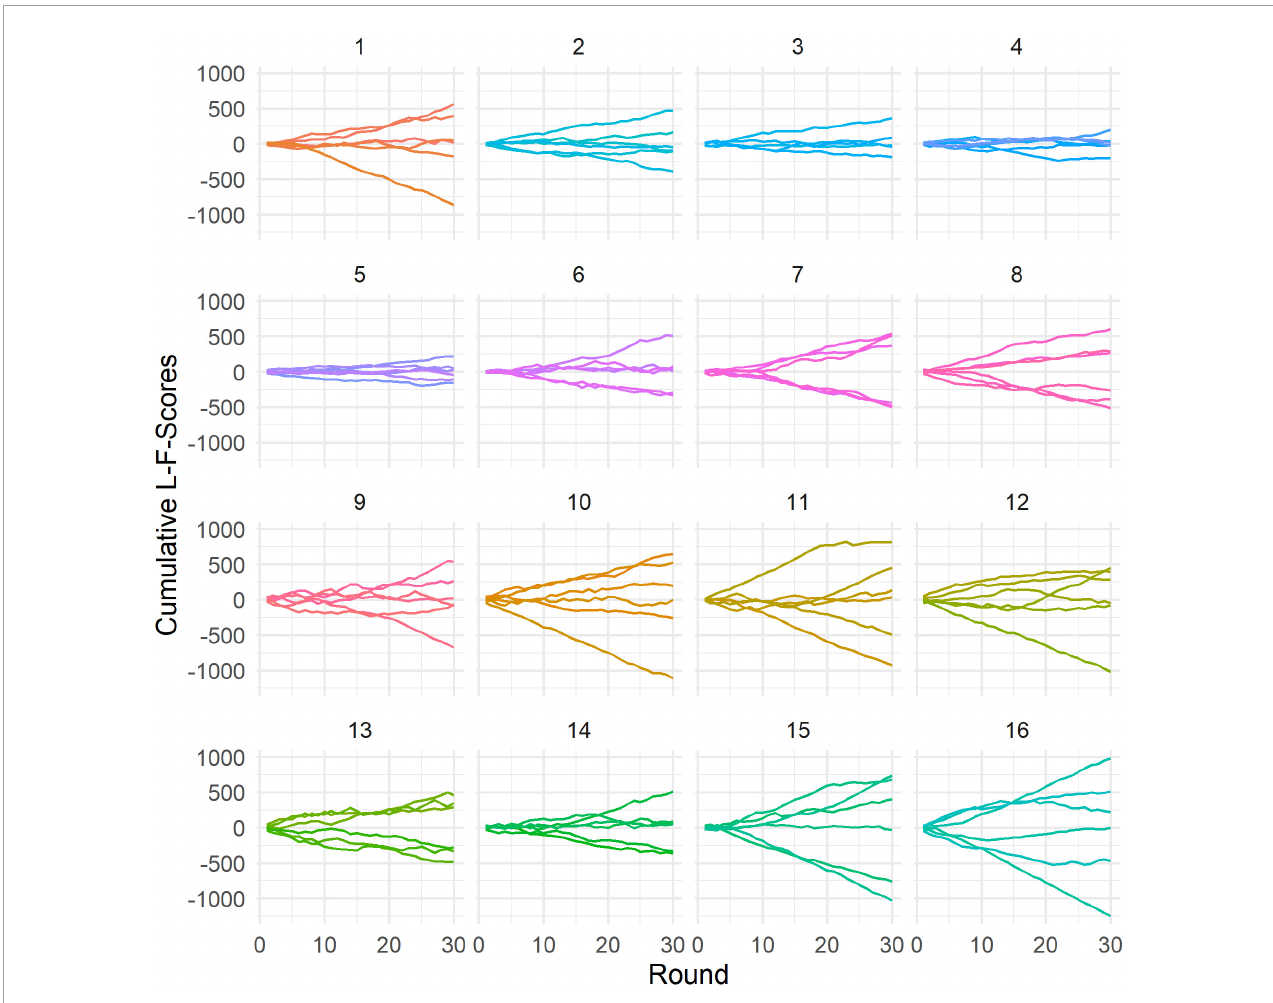
FIGURE7 Cumulative L-F-score sums over rounds. Each panel shows data from one group. Each line represents the cumulative L-F-score sum of one individual participant. Higher scores represent leadership behavioral patterns, while lower scores represent followership behavioral patterns. More divergent cumulative L-F-score sums indicate spontaneous emergence of leader-/follower roles within a